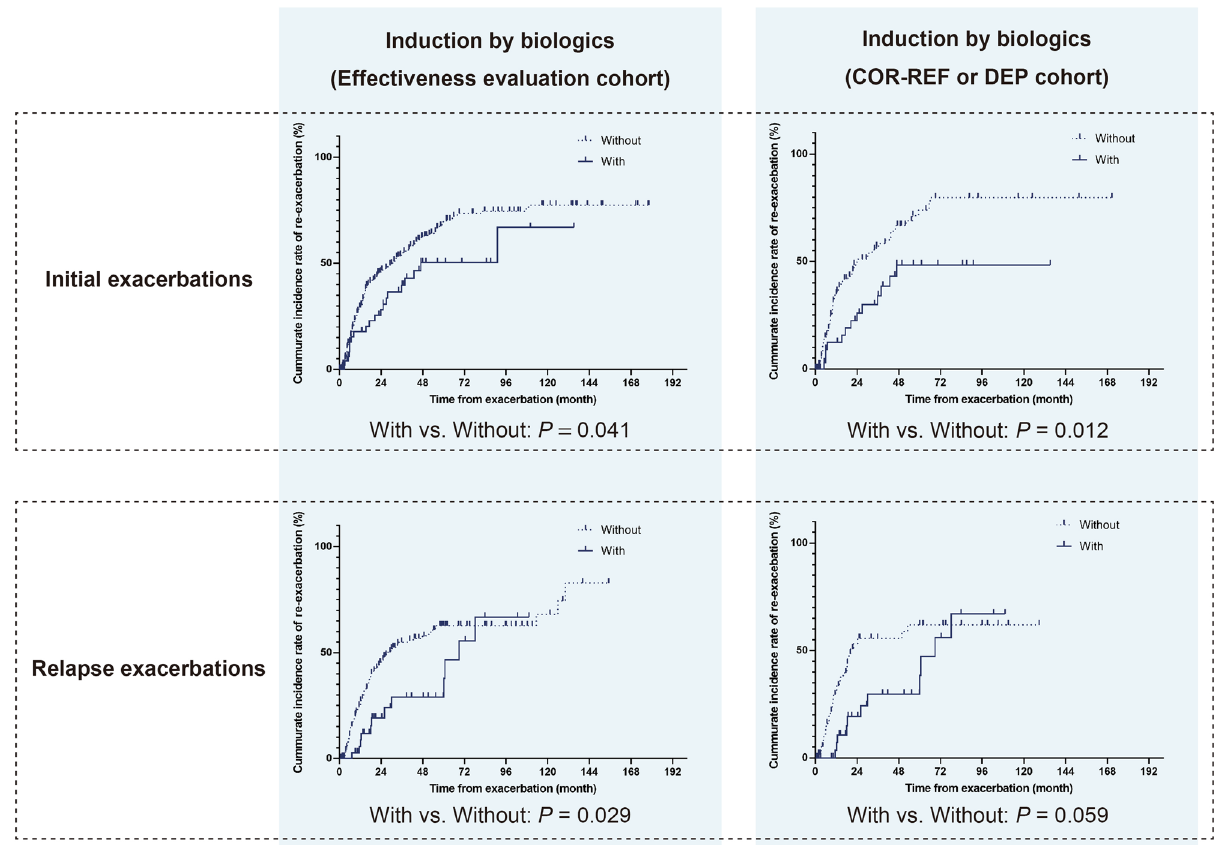
Figure 4. Cumulative incidences of re-exacerbations in patients with moderate to severe ulcerative colitis exacerbations. The left column: the impact of induction of biologics on the cumulative incidence of re-exacerbation in patients with the effectiveness evaluation cohort. The right column: the impact of induction of biologics on the cumulative incidence of re-exacerbation in patients with the COR-REF or DEP